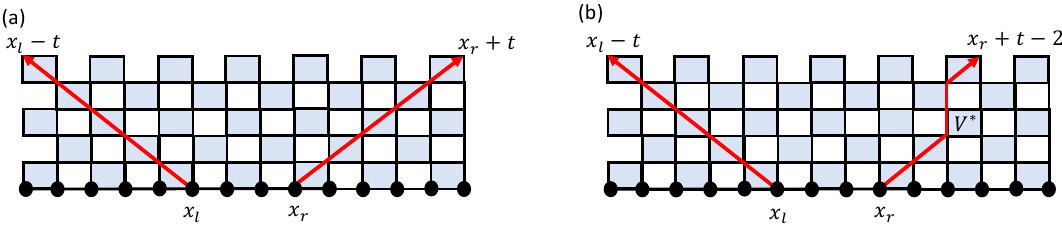
Figure 15 . Time-evolution of operators in the chaotic bath. All shaded rectangles represent unitary matrices V . (a) In a typical operator evolution process, no voids are formed under the action of any V in the circuit, and we see sharp light-cone growth of the operator. (b) When a void is formed under the action of a single unitary matrix V ∗ in the circuit, it shifts the right-endpoint of the final operator away from the edge of the light cone by two